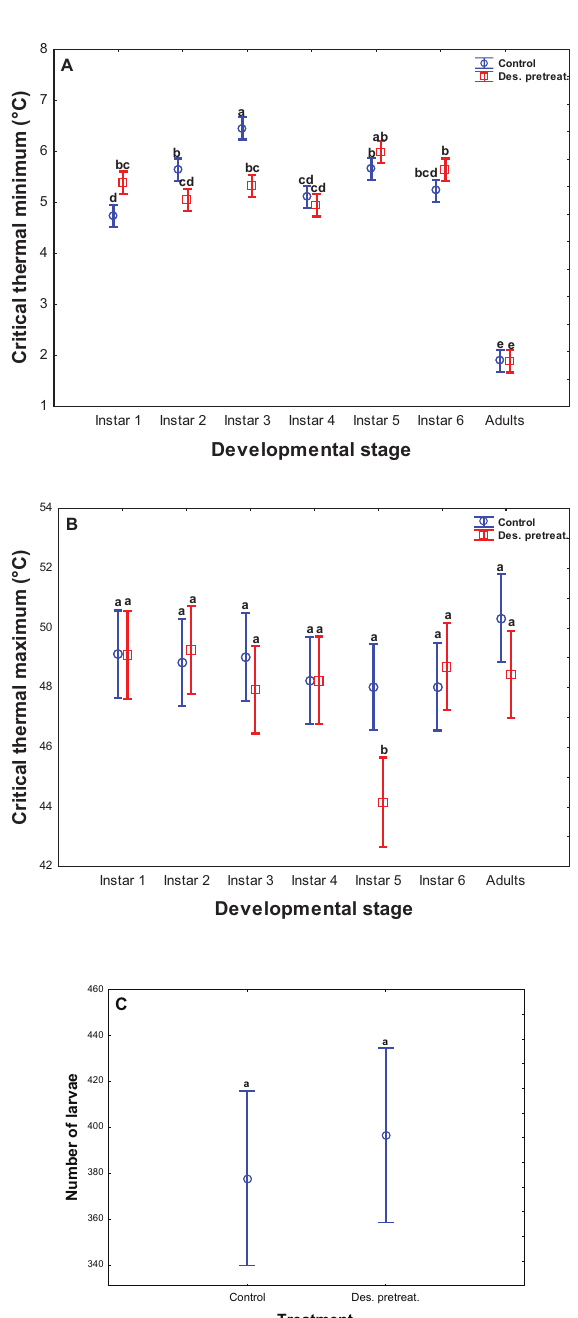
809 Figure 3. Effects of desiccation pre-treatment (des. pretreat.) on critical thermal minimum A critical thermal maximum B for S. frugiperda larvae (all six instars) and adults and C fecundity of S. frugiperda adults. Error bars represent 95% confidence limits (N = 20) and means with the same letter are not sig- nificantly different from each